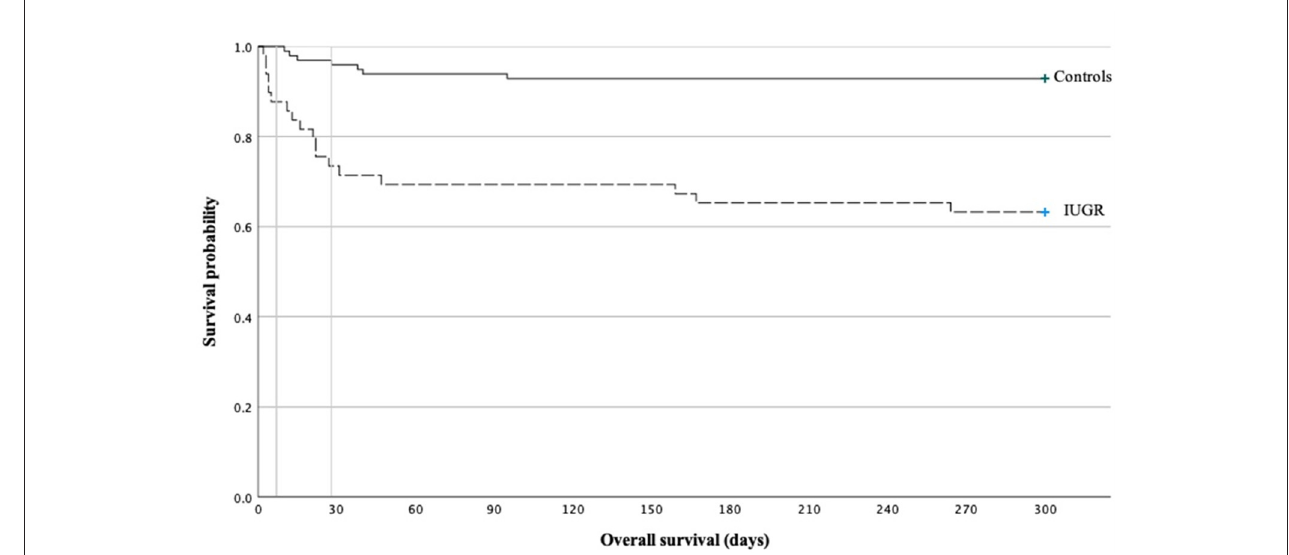
FIGURE 3 | Kaplan–Meier curve on the mortality of ELGAN with severe IUGR vs. controls.